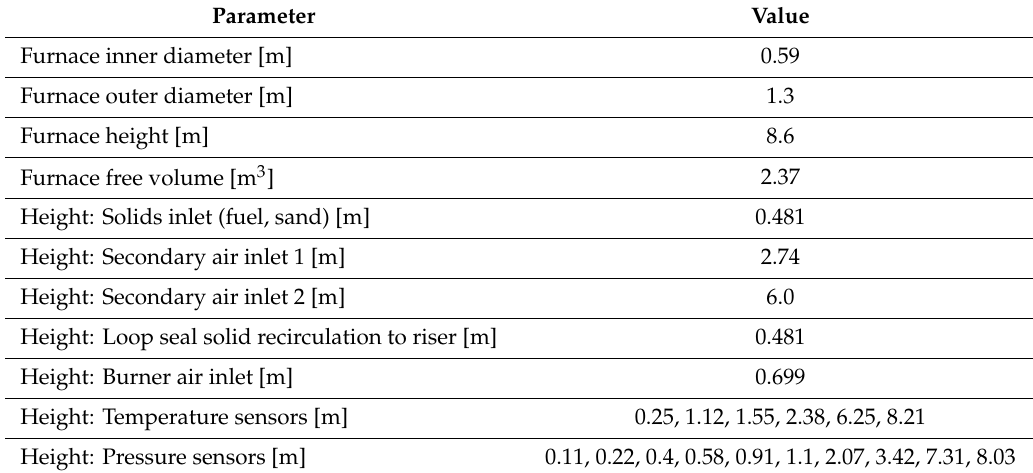
Table 1. Design parameters of the